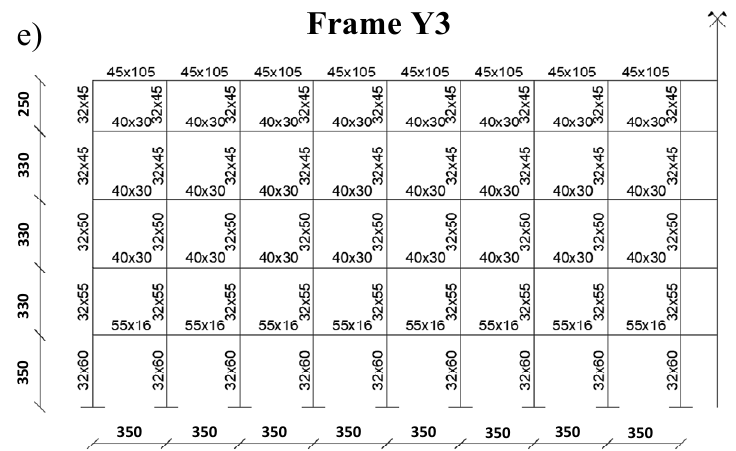
Figure 3. Cross sections of beams and columns pertaining to the main RC frames in X and Y directions. Dimensions reported in [cm]. ( a )Frames X1. ( b ) Frame Y1. ( c ) Frame X2. ( d ) Frame Y2. ( e ) Frame Y3. Table 1. Details of the reinforcements for the different structural members.